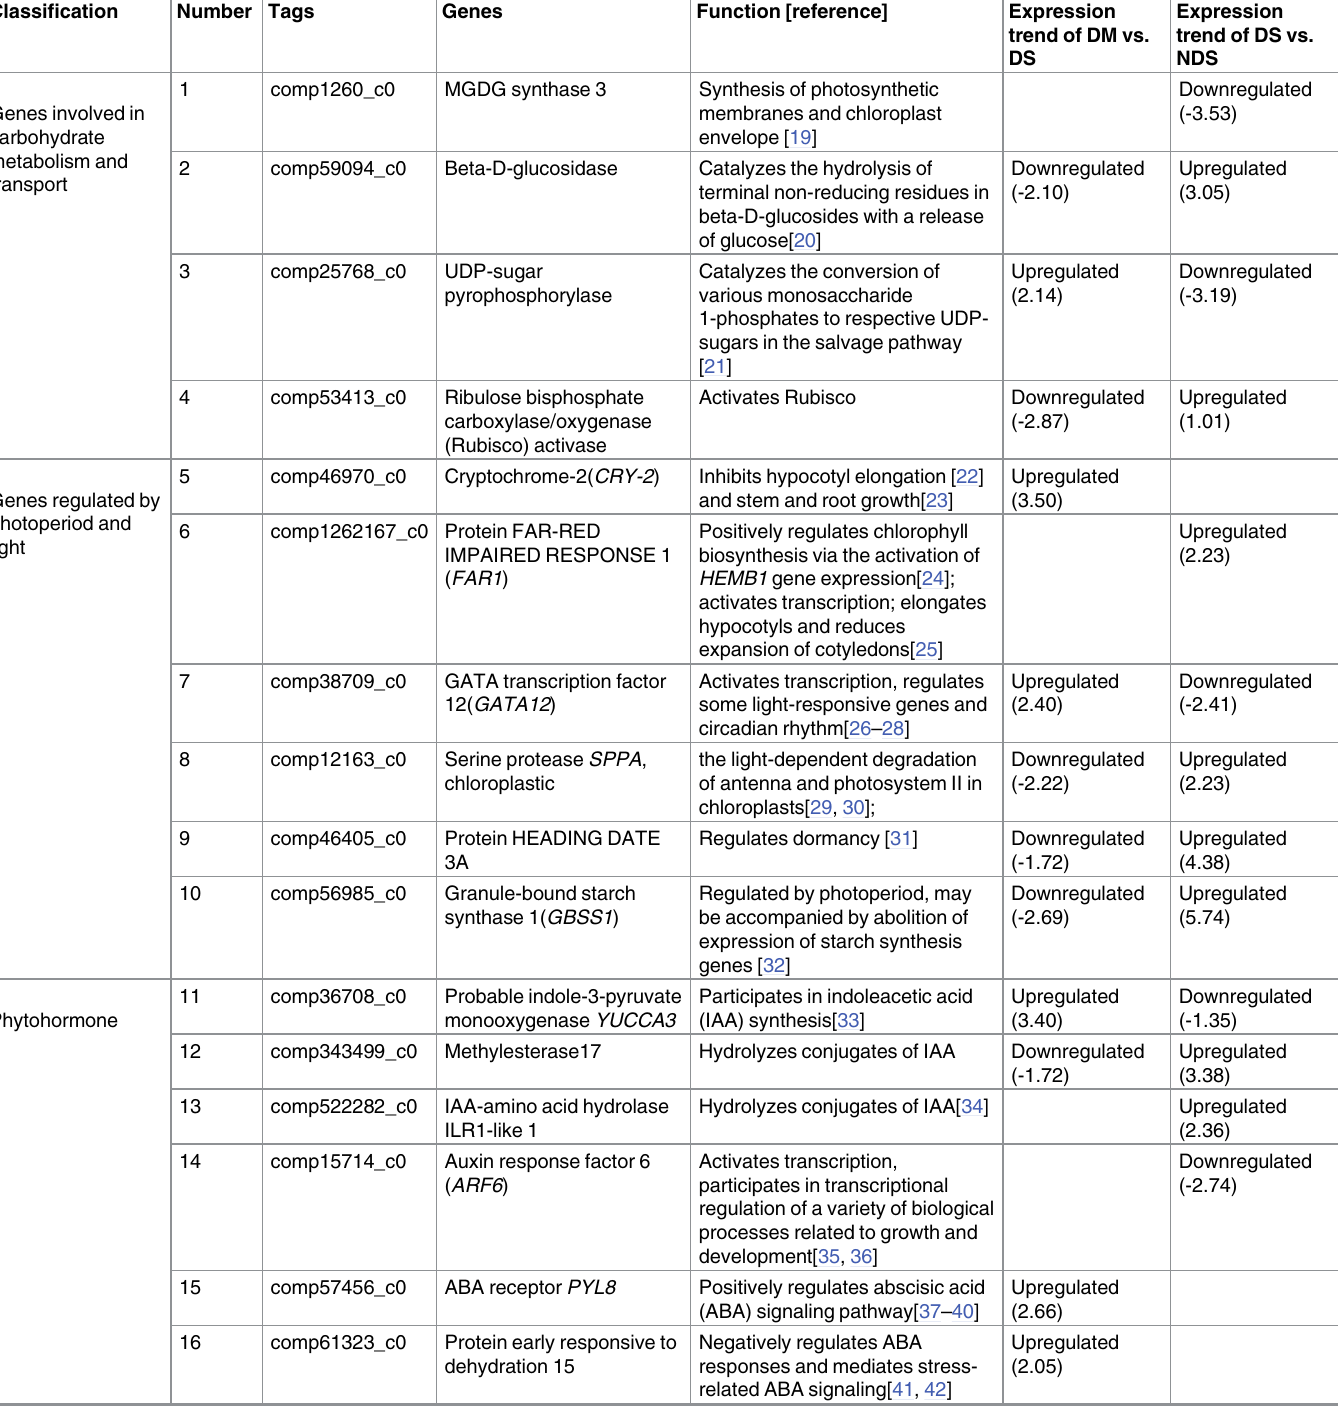
Table 1. Key candidate genes involved in regulating alfalfa fall dormancy.